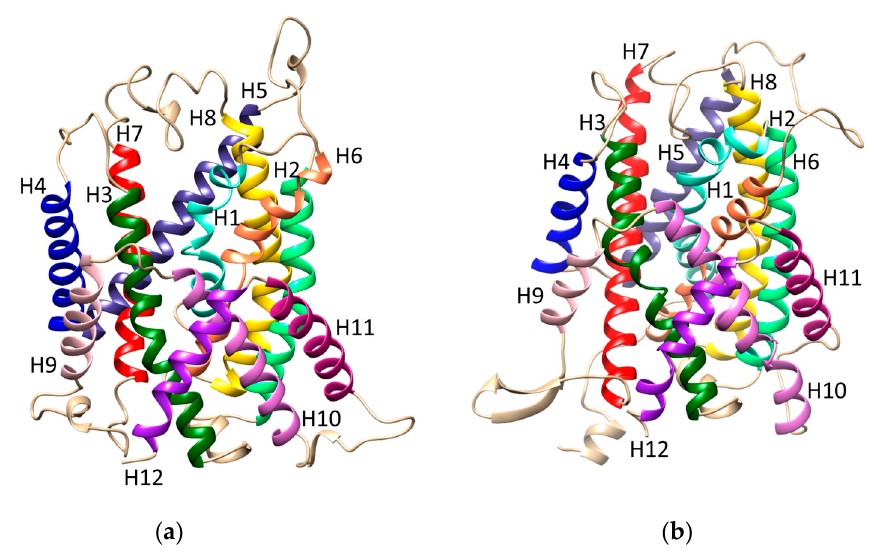
Figure 1. Ribbon representation of LAT1 homology model structures, lateral view of ( a ) the outward-open and ( b ) the inward-occluded conformations, after optimization with Molecular Dynamics. Transmembrane segments are indicated by (H). The extracellular side is the upper part.